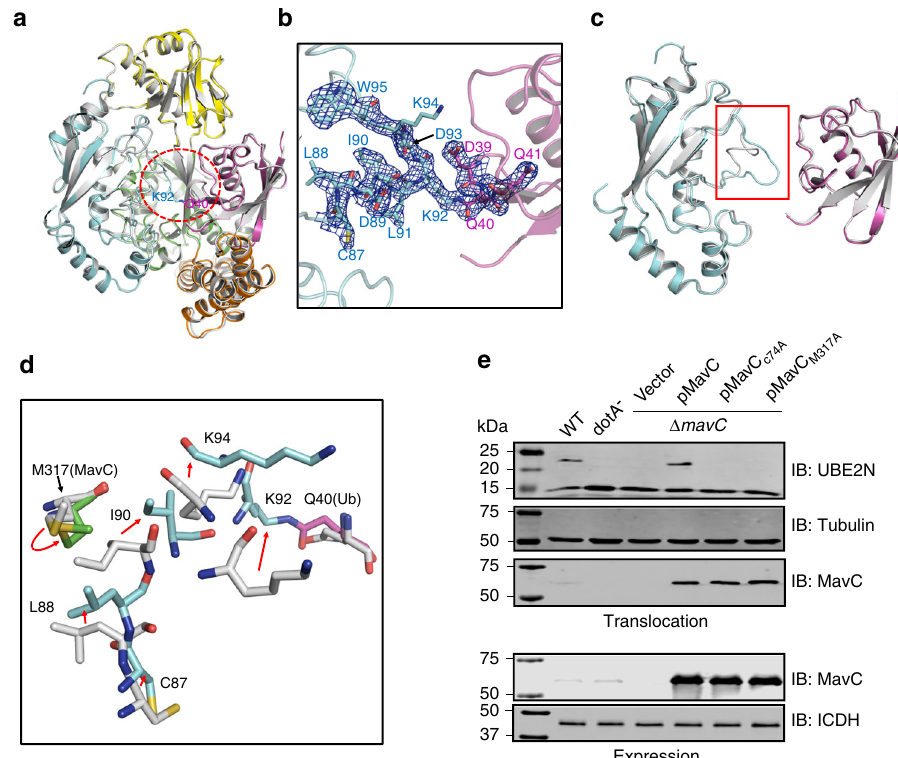
Fig. 3 The conformational change of UBE2N during catalysis. a Structural superimposition between the MavC/UBE2N – Ub binary complex and MavC/ UBE2N/Ub ternary complex. MavC, UBE2N, and Ub in the MavC/UBE2N – Ub binary complex is colored as in Fig. 1a. The MavC/UBE2N/Ub ternary complex is colored in gray. UBE2N K92 and Ub Q40 , which form a covalent bond in the MavC/UBE2N – Ub structure, are shown in sticks. The region of UBE2N which undergoes marked conformational change is indicated by a red circle. b Enlarged view of the UBE2N conformational change region in a . The 2Fo − Fc electron density map contoured at 1 σ is shown in blue mesh for residues 87 – 95 of UBE2N and residues 39 – 41 of Ub in the MavC/UBE2N – Ub binary complex. c Detailed view of the conformational change of the K92/K94 loop of UBE2N. UBE2N and Ub molecules in the two structures are colored as in a . The region with the conformational change is highlighted in a red box. d Detailed view of the conformational change of UBE2N. The MavC/UBE2N – Ub binary complex and MavC/UBE2N/Ub ternary complex are colored as in a . Representative residues of the three proteins in the two structures are shown in sticks. The red arrows indicate the movement of the residues from the resting state to the catalytic state. e MavC M317A is defective in inducing UBE2N modi fi cation during L. pneumophila infection. Cells were infected with wild-type (WT) L. pneumophila or its dotA mutant defective in the Dot/Icm type IV transporter or mavC complementation strains. Saponin-soluble cell lysates were resolved by SDS – PAGE and probed with indicated antibodies to detect the ubiquitination of UBE2N (top) and the translocation of MavC and its mutants (middle). Bacterial lysates were probed for the expression of MavC and its mutants (bottom). Tubulin and ICDH were probed as loading control, respectively. Source data are provided as a Source Data fi le. The experiment was repeated independently three times with similar